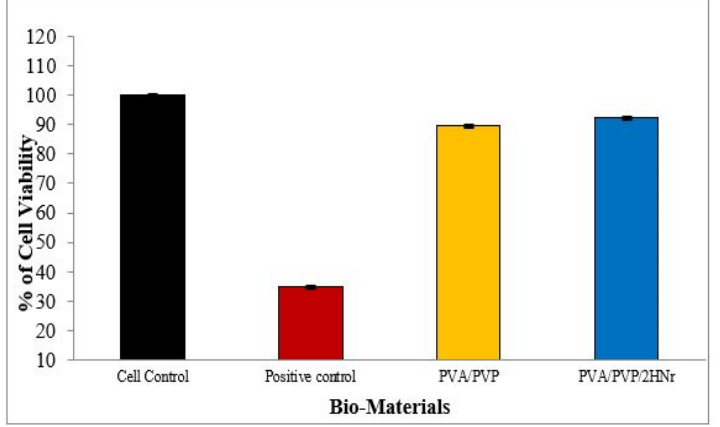
Figure 8 . hMSC cell Viability of PVA/PVP and PVA/PVP/2HNr hydrogel after 72 h cell culture . Figure 8. hMSC cell Viability of PVA/PVP and PVA/PVP/2HNr hydrogel after 72 h cell